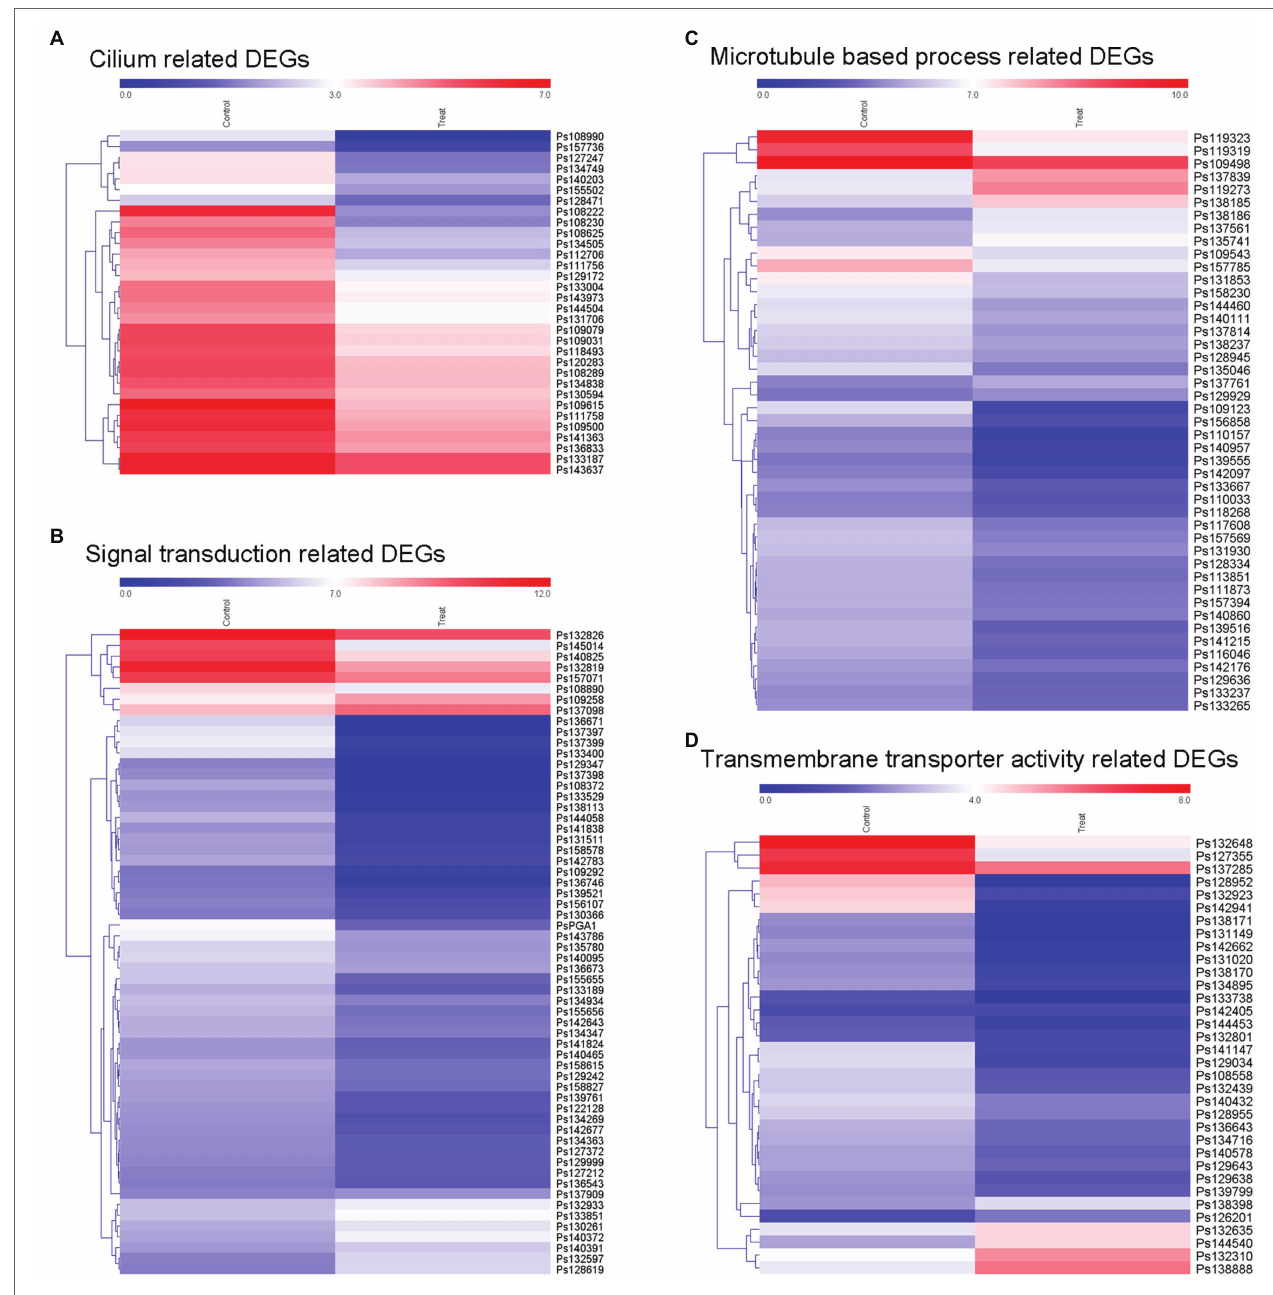
FIGURE 7 | Expression of different groups of genes associated with sporangia formation under lovastatin treatment. The GO terms of DEGs are associated with signal transduction, assembly of zoospore structures, and transport of necessary components. The expression changes of different groups of (A) cilium-related genes, (B) signal transduction-related genes, (C) microtubule-based process-related genes, and (D) transmembrane transporter activity-related genes were clustered and visualized in a heatmap.